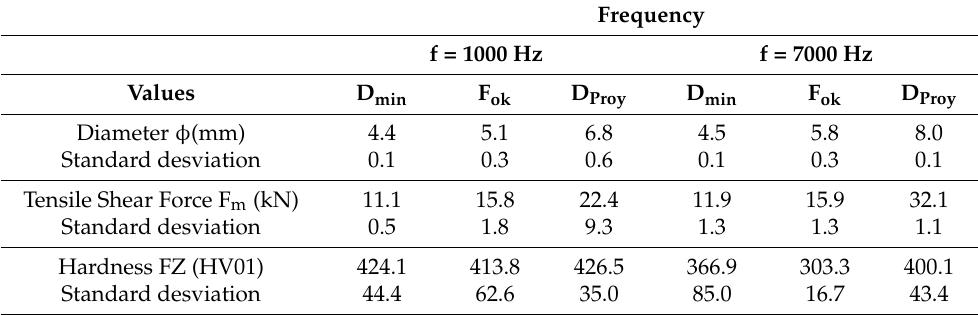
Table 5. Mechanical characteristics. Weldability lobe.